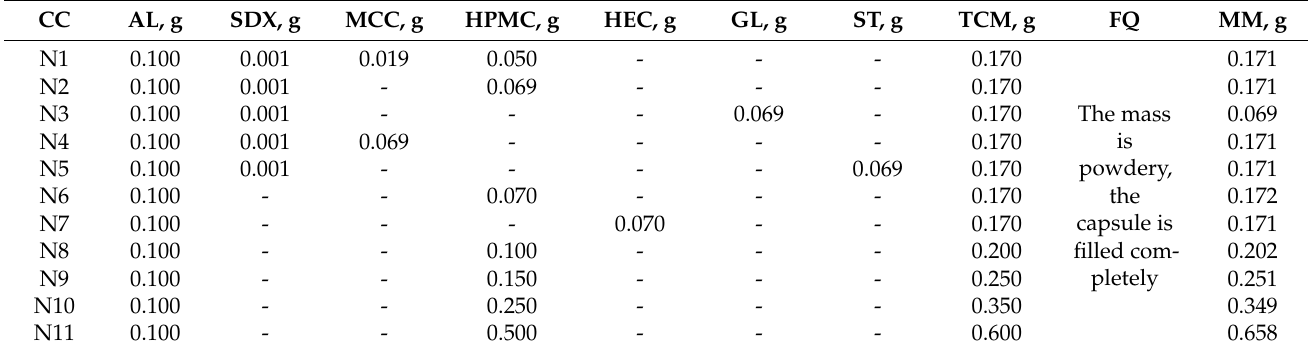
Table 1. Compositions of the apple lyophilisate-containing